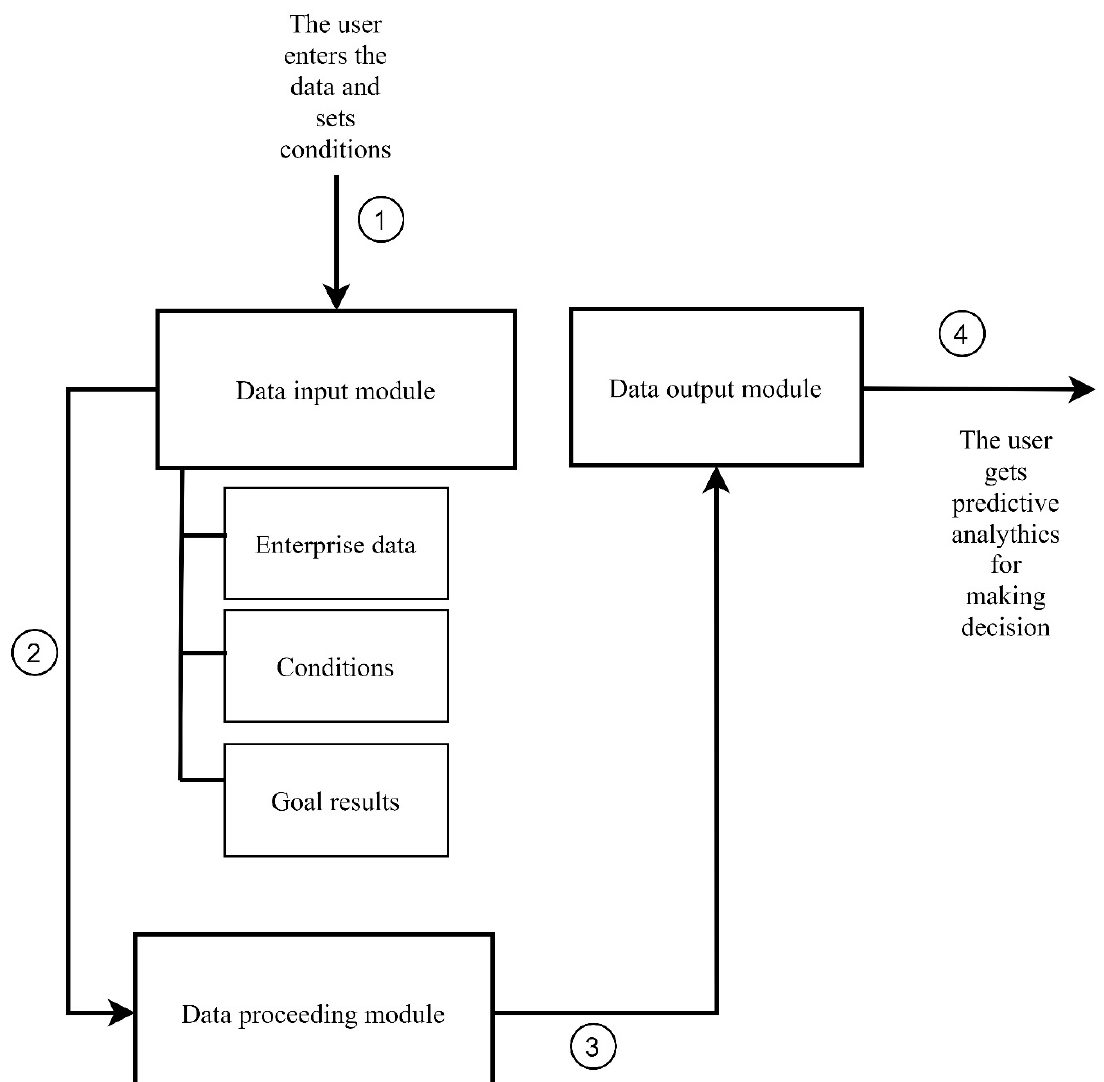
Figure 1. Description of the DSS modules.